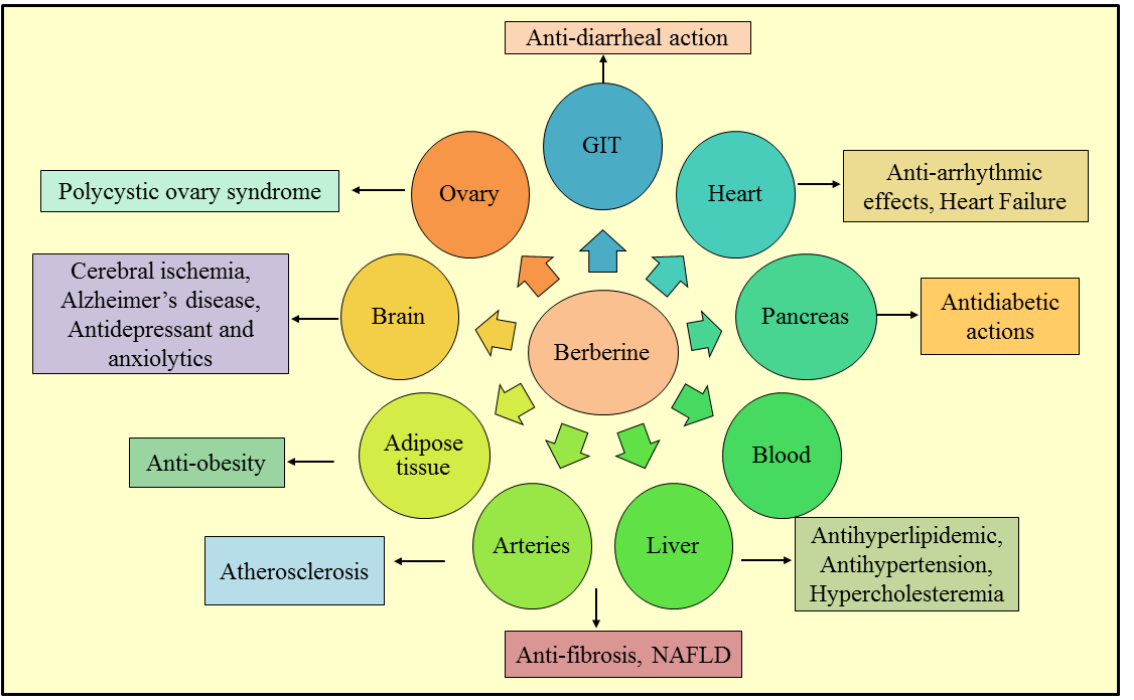
Figure 2. Schematic representation of various pharmacological actions exerted by berberine on different organs in the human body. NAFLD—non-alcoholic fatty liver disease, GIT—gastrointestinal tract.